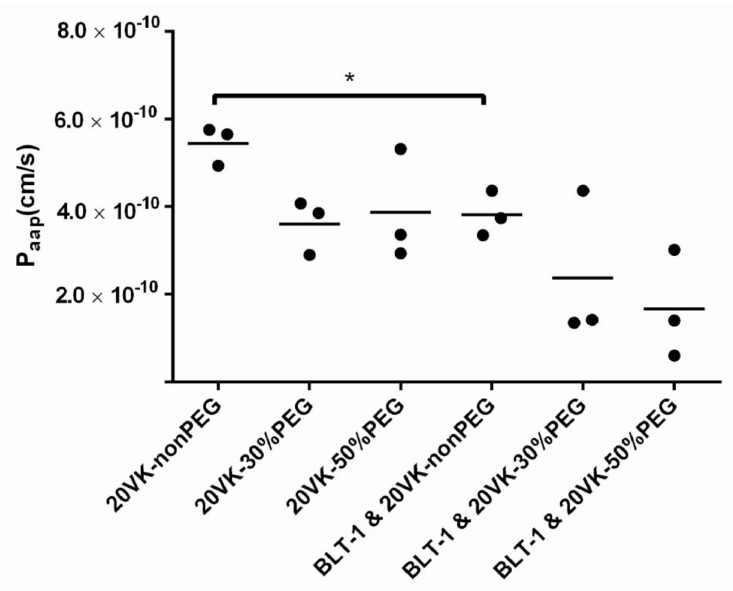
Figure 1. Permeability coefficients of vitamin K (350 µ M) loaded in mixed micelles (non-PEG, 30%-PEG and 50%-PEG with the lipid concentration of 1.58 mM) in differentiated Caco-2 cells with and without pre-incubation with 10 µ M BLT-1, shown as mean of triplicates for each group (two-tail unpaired t -test, * p <